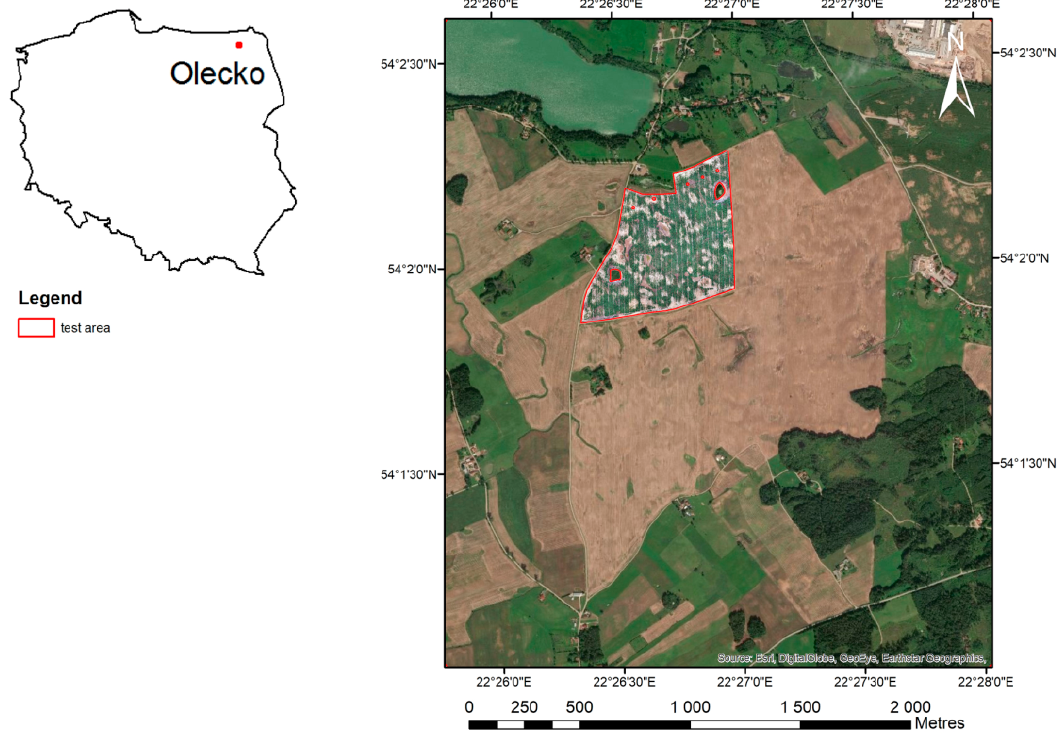
Figure 2. Test area, rapeseed field in Olecko, Poland.